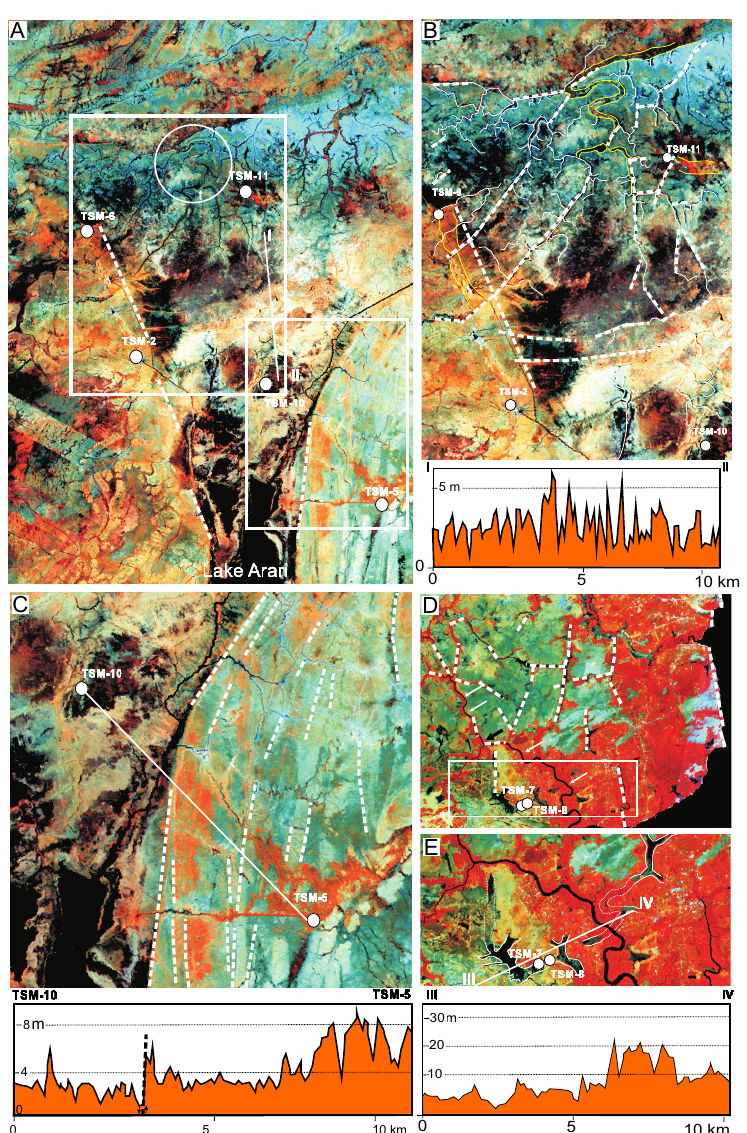
Fig. 4 – Landsat images, composition = 4(R), 5(G), 7(B), illustrating areas between drills, where drainage lineaments are related to tectonic activity. A) Location of drills TSM-2, TSM-5, TSM-6, TSM-10 and TSM-11 at the mouth of the large Arari paleoestuary to the north of